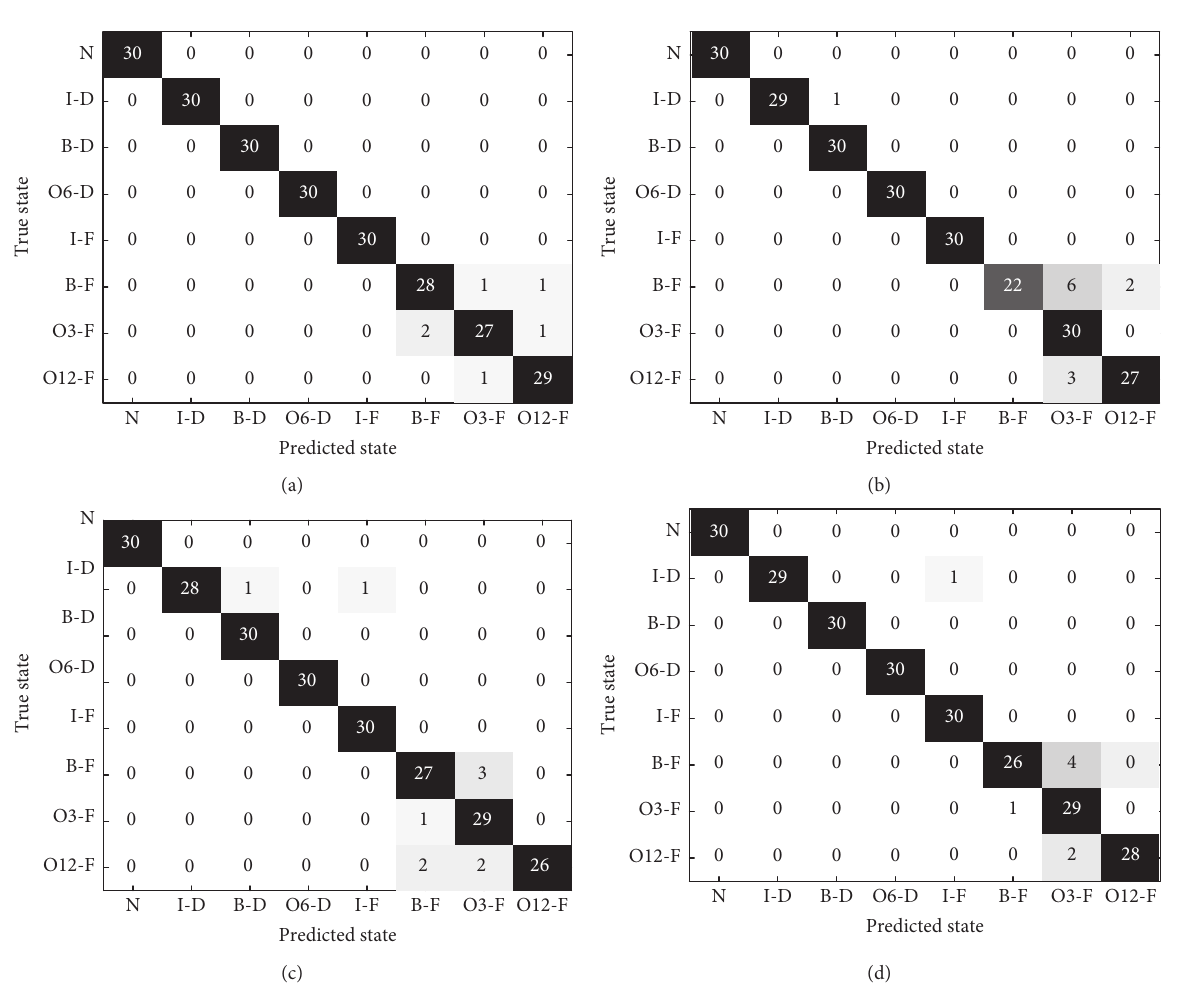
Figure 9: Classification results of (a) MKL-SVM, (b) SVM, (c) GA-SVM, and (d)